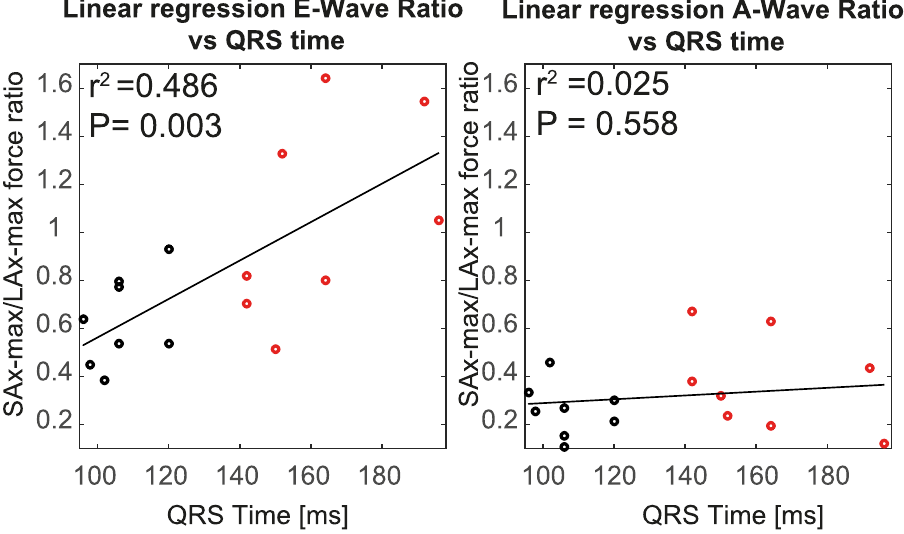
Figure 2. Regression analysis of the “SAx-max force/LAx-max force”-ratio versus the QRS duration for (left panel) E-wave and (right panel) A-wave. The black solid line is the best fit of a line to the data; red circles represent the non-LBBB patients and black circles the LBBB